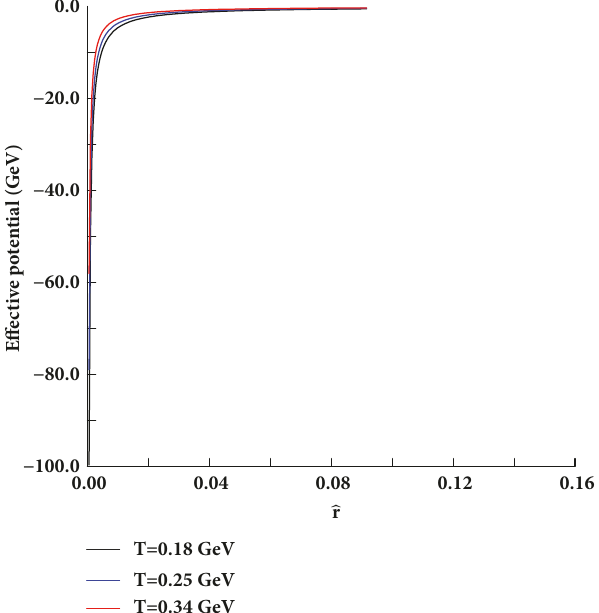
Figure 2: The potential divided by ( 𝑔 2 𝐶 𝑓 𝑚 𝑑 ) is plotted as a function of ̂𝑟 at zero chemical potential and N = 3 for different values of